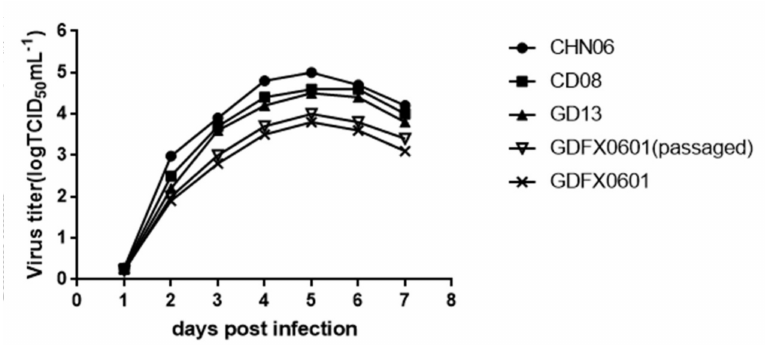
Figure 6. Replication of the GD13 (ALV-A), CD08 (ALV-B), CHN06 (ALV-J), and GDFX0601 in DF-1 cells.